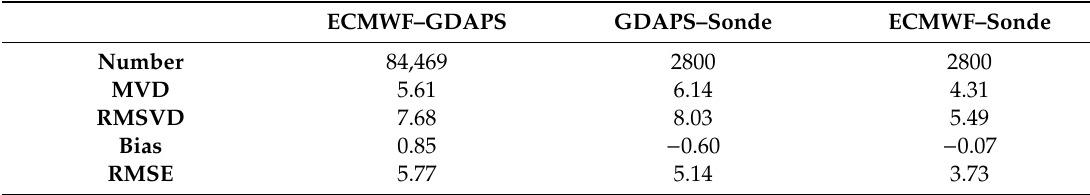
Table A7. Comparisons of GDAPS and Era-Interim ECMWF model data. They are collocated against GK-2A AMVs with CLD and CTP from NOAA / NESDIS, considering CQIF > 80, at 05:40 and 12:10 UTC on 21 July 2016. Results show that U and V of ECMWF profiles are more consistent with the corresponding rawinsonde than those of